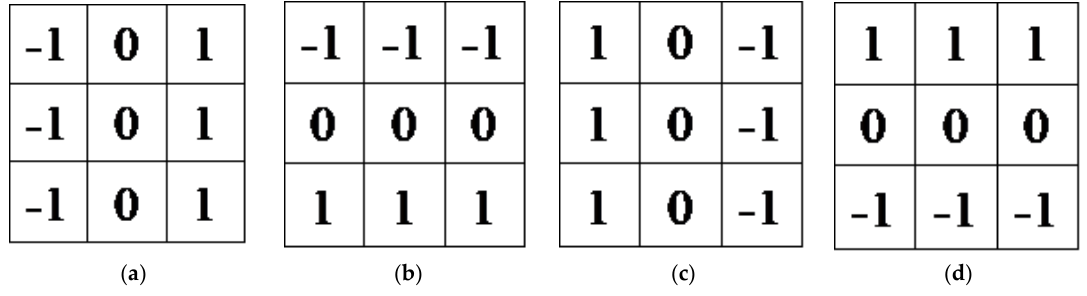
Figure 2. The convolution templates for edge detection. ( a ) 0°. ( b ) 90°. ( c ) 180°. ( d ) 270°. After extraction of multiple edge features edge X , in order to prevent abnormal sample data